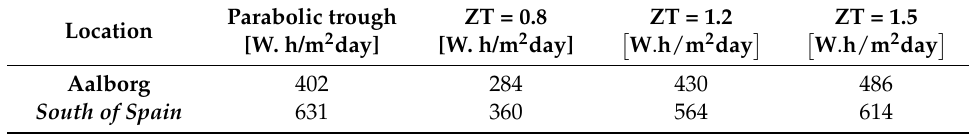
Table 6. The daily energy production in Aalborg and Gibraltar for different values of ZT compared with the parabolic trough.